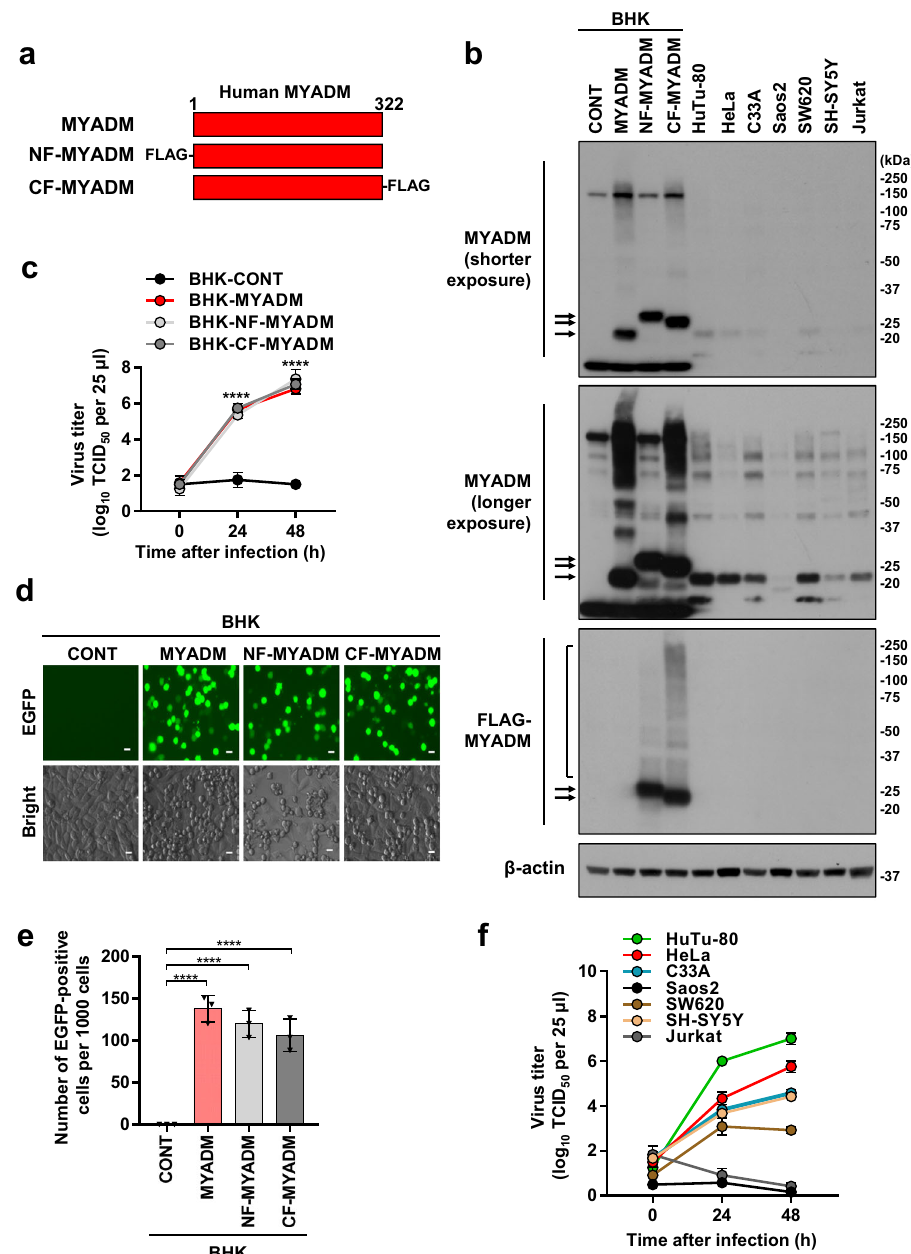
Fig. 2 | MYADM expression on PeV-A3 non-susceptible cells induces PeV-A3 infection.a AschematicillustrationofthestructureofthehumanMYADMprotein that was used. b Cell lysate was prepared from the indicated cells, and the expressionlevelsofendogenousMYADM,FLAG-MYADM,and β – actinincelllysates were characterized by Western blotting. Representative Western blots of two independent experiments ( N =2) are shown; the two experiments gave similar results. c , f The indicated cells were infected with PeV-A3 (A308/99) at an MOI of 0.01,andthe amountofvirus (virus titer)inthe culturesupernatantwasmeasured at0,24and 48h afterinfection. The virus titersinthe culturesupernatant of BHK- CONT (black circle), BHK-MYADM (red circle), BHK-NF-MYADM (light gray circle), BHK-CF-MYADM (dark graycircle),HuTu-80(green circle),HeLa(red circle), C33A (bluecircle),Saos2(blackcircle),SW620(browncircle),SH-SY5Y(peachcircle)and